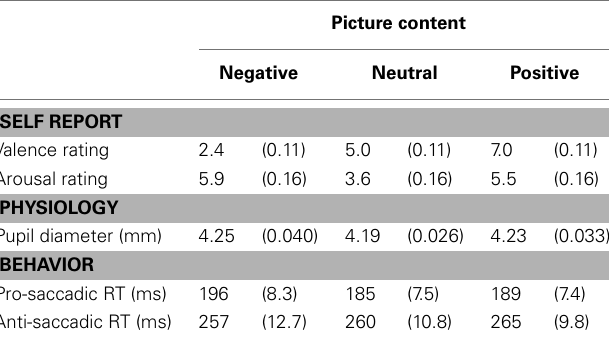
Table 1 | Emotion and performance measures as a function of picture content (table shows means and SE between